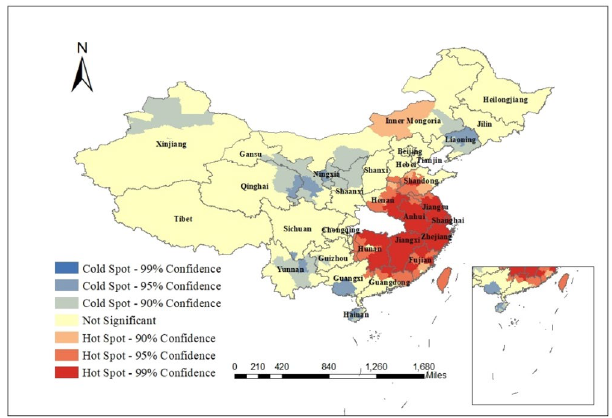
Figure 3. The results of local spatial autocorrelation of cumulative confirmed cases in cities other than Hubei Province in March 12. The map was generated by ArcGIS (http://www.esri.com/softw are/arcgi s/arcgi s-for-deskt op/free-trial